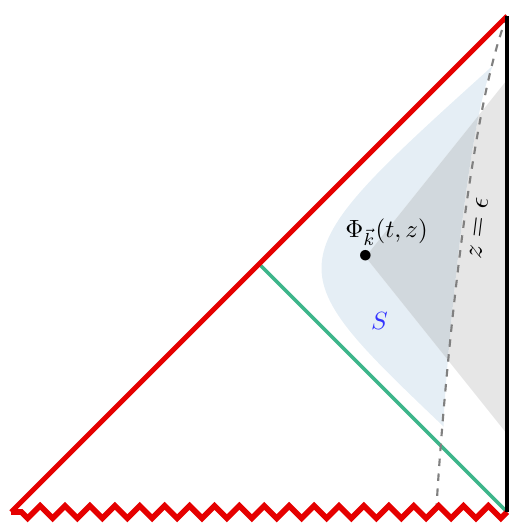
in gray for a given point in region I and its (cid:31)k